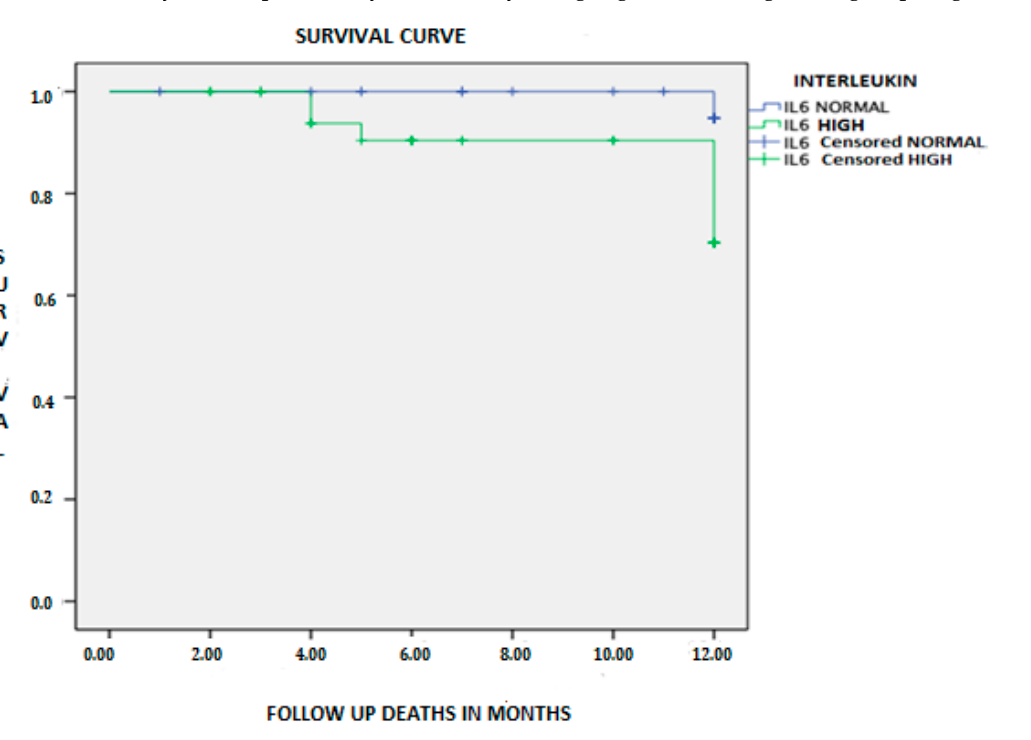
Figure 1. Kaplan–Meier survival curve of patients with heart failure in both groups according to interleukin-6 (IL-6) level.